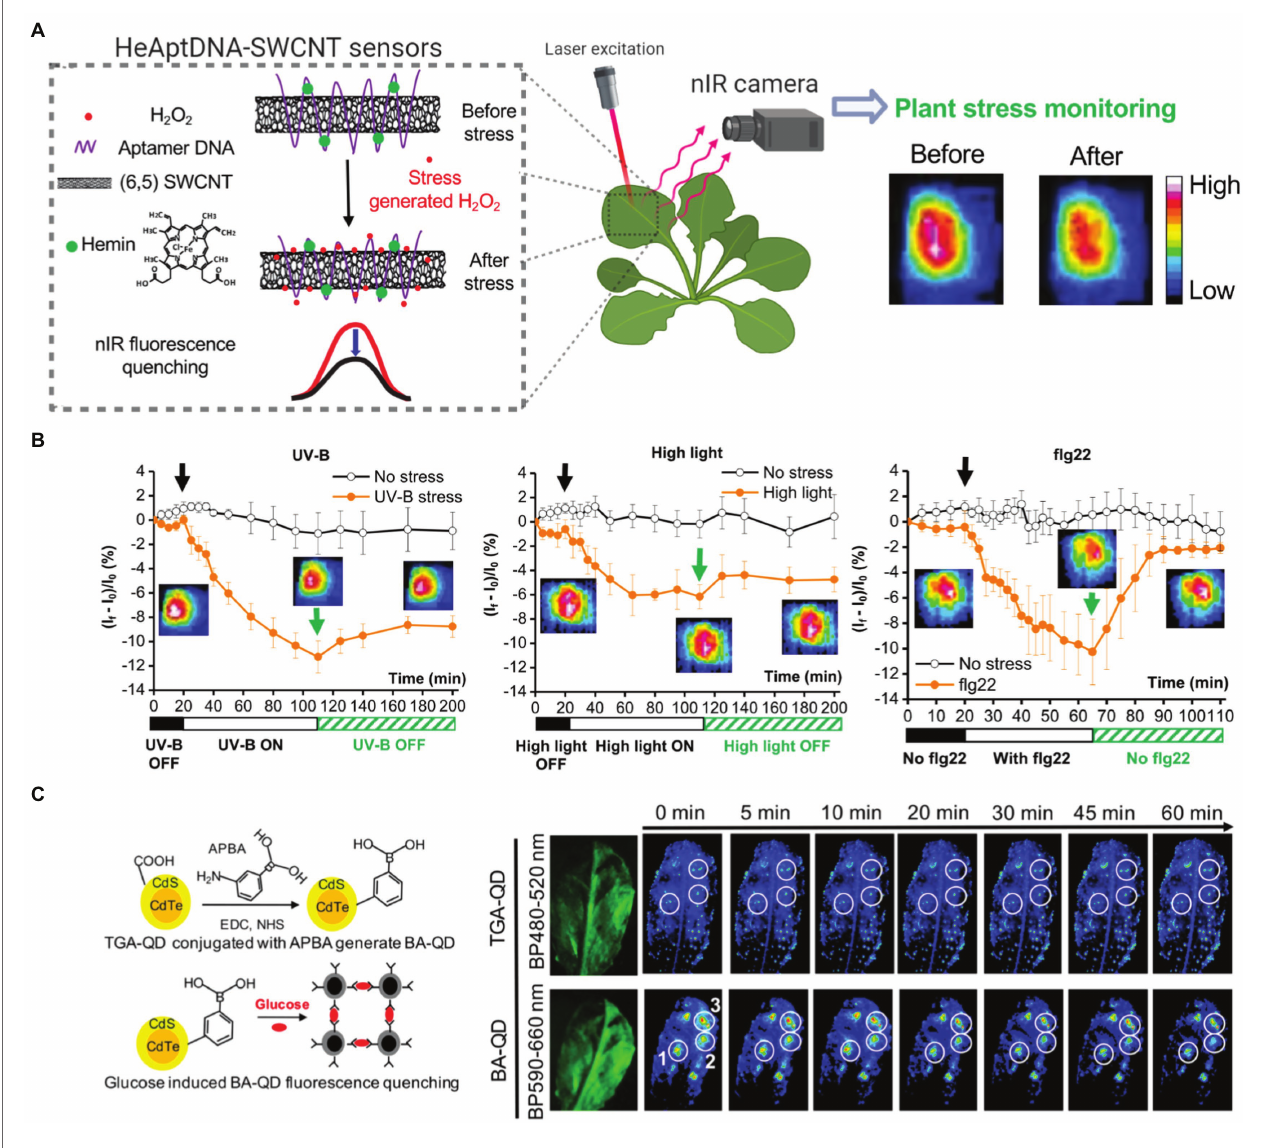
FIGURE 5 | Plant health monitoring by nanotechnology-based sensors. (A) Single-walled carbon nanotubes (SWCNTs) can be functionalized with aptamer DNA and hemins to detect H 2 O 2 , a signaling molecule associated with plant stress. SWCNT sensors report H 2 O 2 in real-time by quenching in NIR fluorescence intensity The nanosensor fluorescence changes are monitored by a NIR imaging before and after the stress event. This standoff detection via NIR imaging can report stress events within the plant physiological range of H 2 O 2 (10–100 μ m; Wu et al., 2020). (B) SWCNT-based nanosensors allow early detection of stresses from UV-B, high light, and a pathogen-related peptide (flg22; Reprinted with permission from Wu et al., 2020). (C) Boronic acid-coated quantum dots (BA-QDs) can act as glucose sensors, a principal product of chloroplast photosynthesis. Standoff glucose detection of A. thaliana is enabled by nanosensors excited through UV light and imaged with a Raspberry Pi camera (Reprinted with permission from Li et al., 2018). Thioglycolic acid-coated quantum dots (TGA-QD) act as internal controls that do not respond to